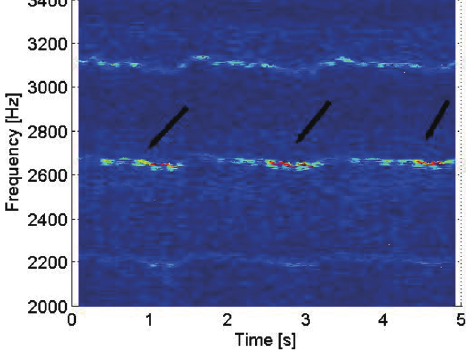
Fig. 19. STFT applied to accelerations measured on the DU